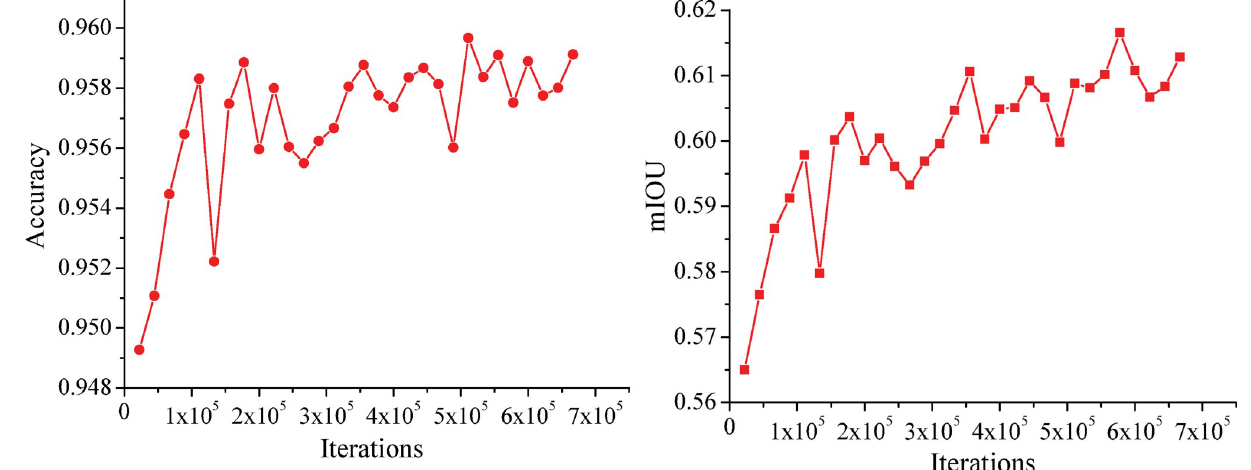
Fig 8. Graphs of the accuracy and mIoU achieved on the validation set. (a) Accuracy. (b) mIoU.